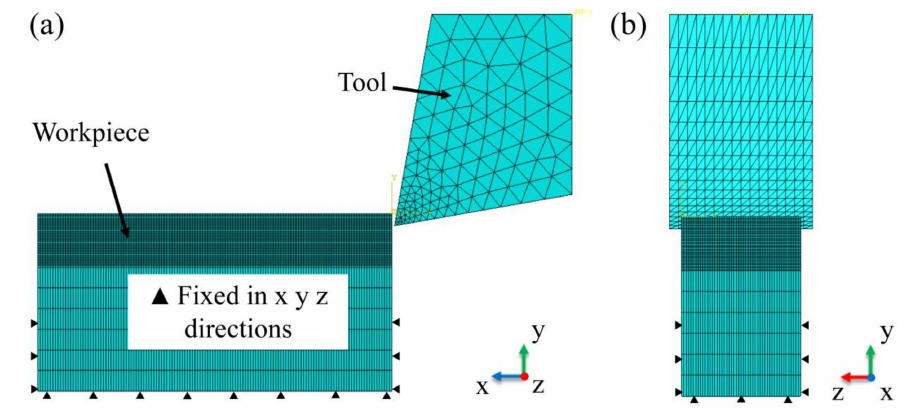
Figure 3. 3D finite element cutting model ( a ) front view ( b ) left view.